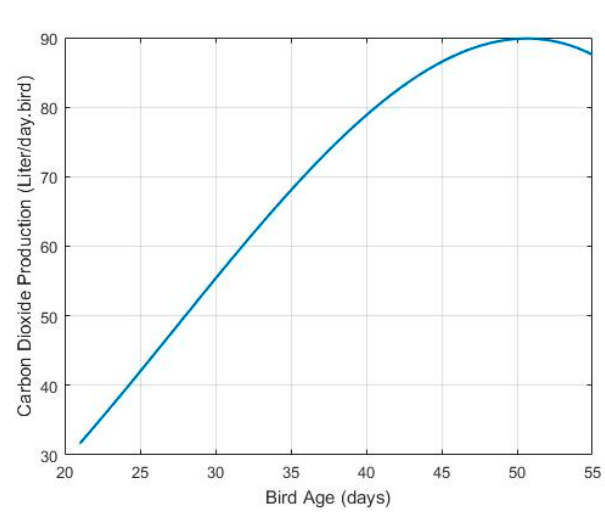
Figure 5. Carbon dioxide production curve.